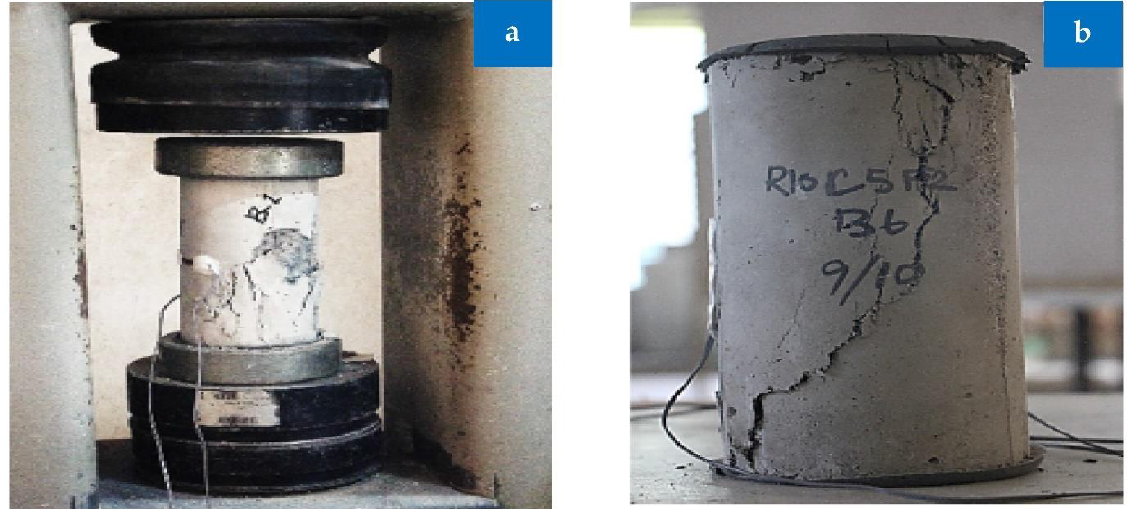
Figure 14. Cylinder failure under compression: ( a ) reference and ( b ) combination of RCA, rubber, and fibers [44]: used as per Elsevier permissions.